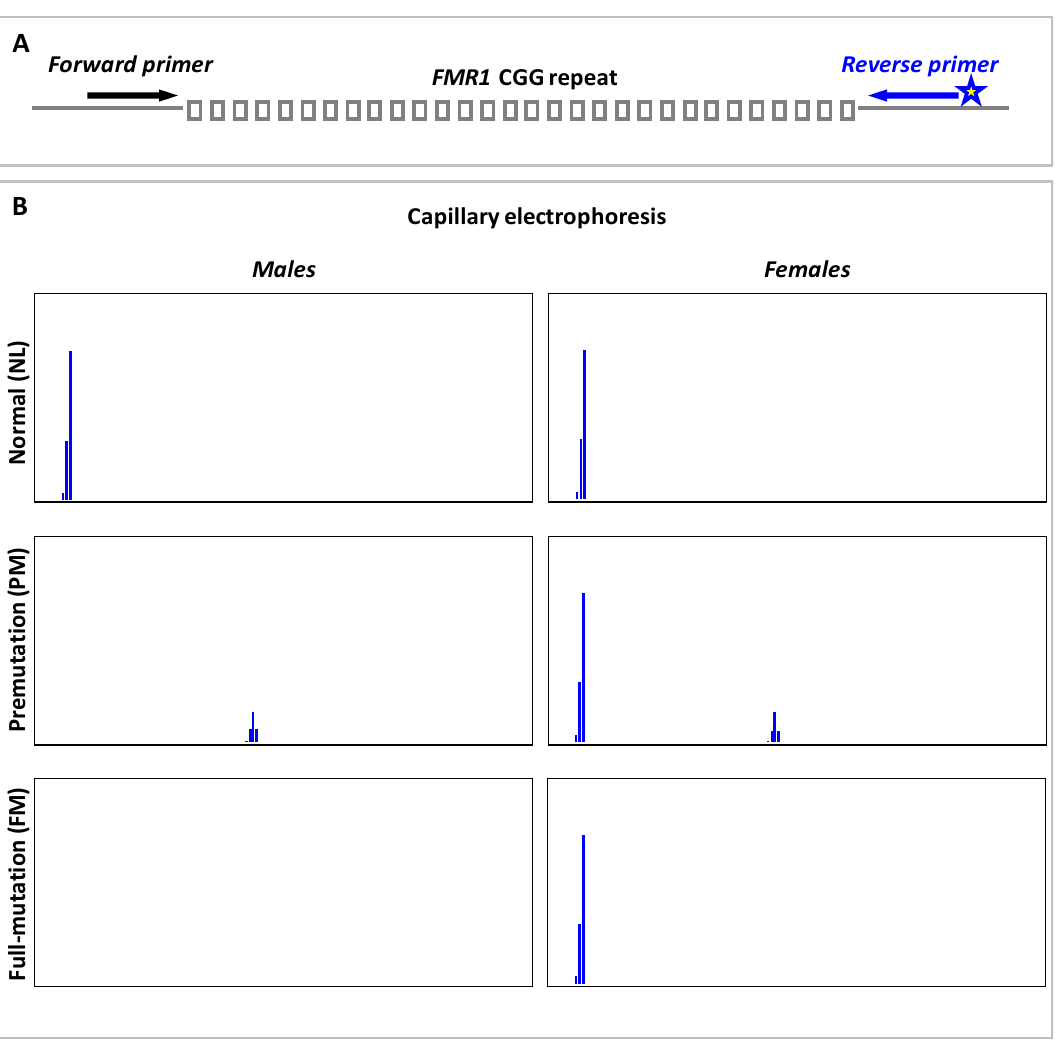
Figure 1. Flanking or repeat ‐ spanning PCR: ( A ) Schematic depicting the flanking PCR primer design; and ( B ) expected capillary electrophoresis profiles of normal, premutation and full ‐ mutation males and females.